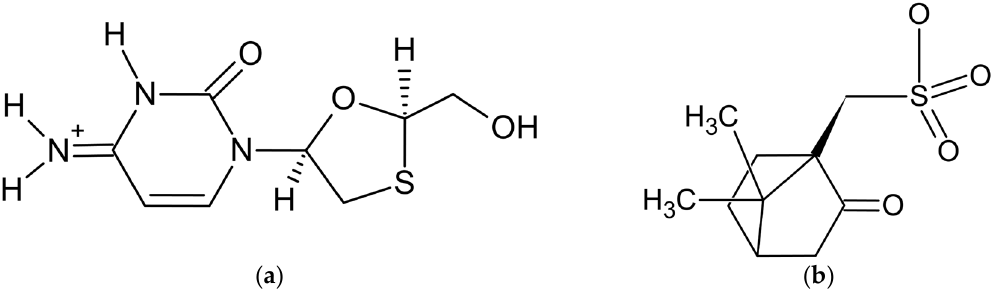
Figure 1. Components of lamivudine camphorsulfonate (1:1) salt: ( a ) lamivudine cation and ( b ) cam- phorsulfonate anion.